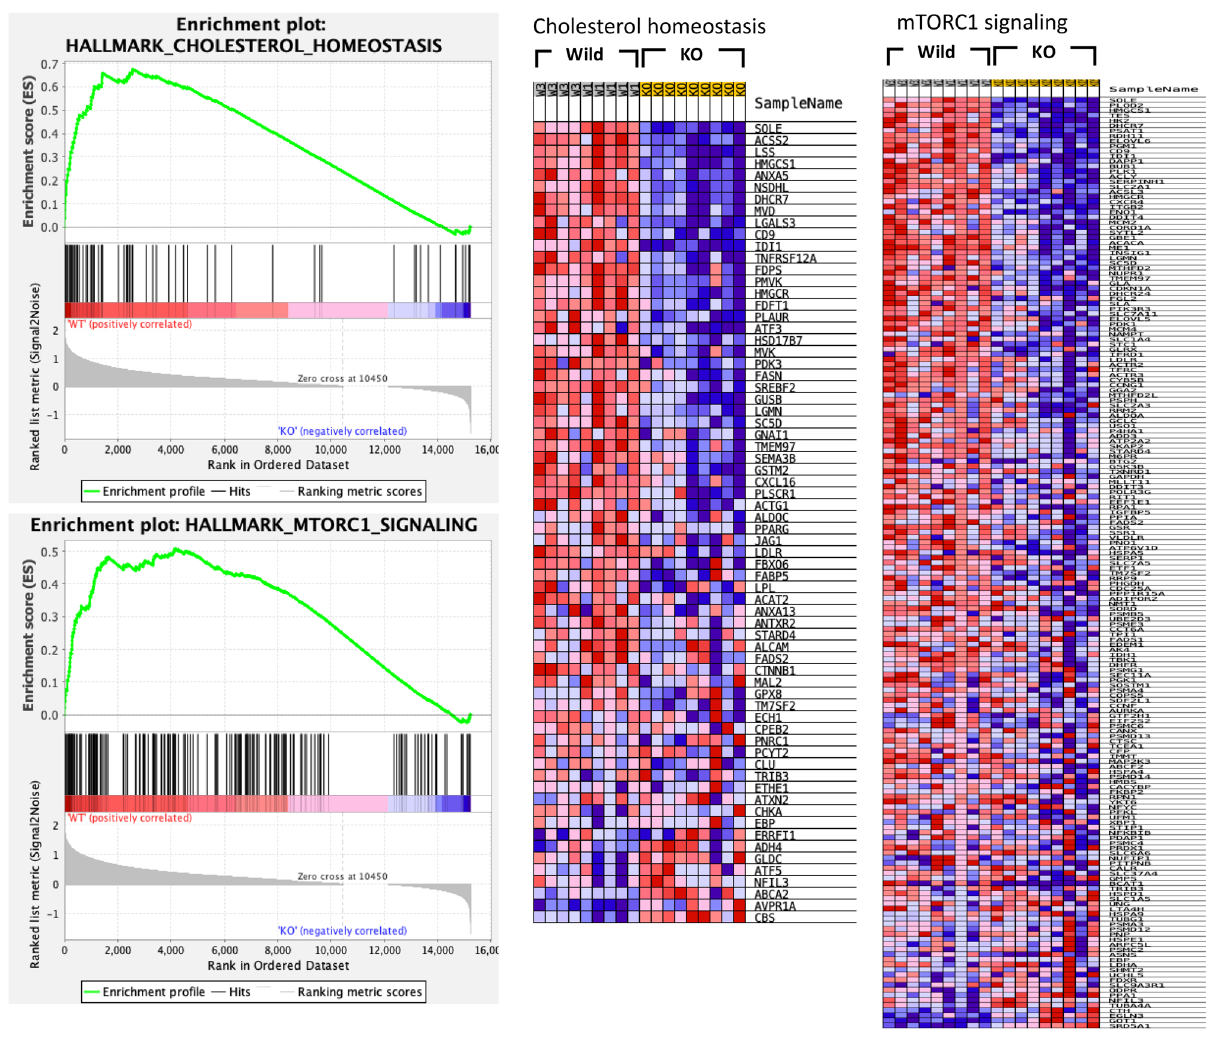
Figure 3. Gene set enrichment analysis of liver RNA sequences in the liver of wild-type and KO mice. Enrichment plots and heat maps are shown for gene sets of cholesterol homeostasis and mTORC1